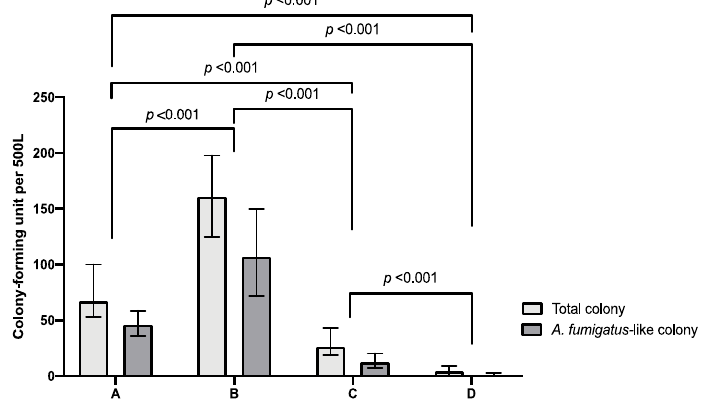
Figure 1. The median and interquartile range (IQR) of total fungal and A. fumigatus -like colonies in the air of different hospital environments. Negative pressure rooms (A), slightly negative pressure rooms (B), neutral pressure rooms in ordinary wards (C), and rooms in a liver intensive care unit with high-efficiency particulate air filter (D). The highest air fungal burden, either total fungal colonies or A. fumigatus -like colonies, was found in the slightly negative pressure rooms (B). In addition, there were higher airborne fungal concentrations in both negative and slightly negative pressure rooms (A,B) arranged for COVID-19 patients than the rooms in the ordinary ward (C) and liver intensive care unit with high-efficiency particulate air filter